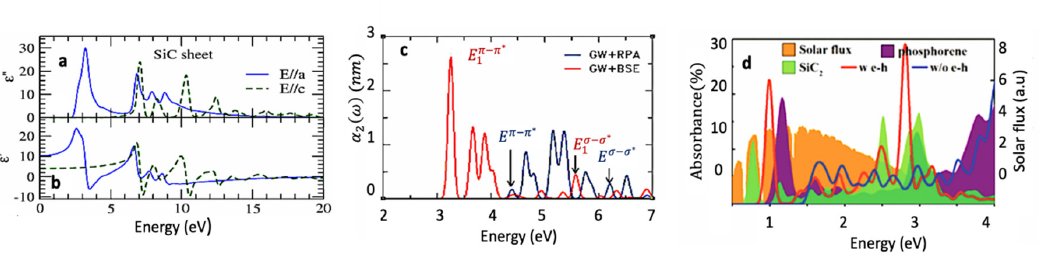
Figure 4. Optical properties of 2D silicon carbide materials. ( a , b ) Dielectric functions vs. photon energy in a single SiC sheet. The imaginary ( a ) and real ( b )parts of the dielectric function for the electric field parallel (blue line) and perpendicular (green line) to the SiC sheet [53]. ( c ) Optical absorption spectra of monolayer SiC using GW + RPA (blue) and GW + BSE (red) calculations [4]. α 2 is related to the imaginary part of the dielectric and it is imaginary part of the polarizability per unit area for a SiC sheet [4]. ( d ) Optical spectra of SiC 7 (orange, red and blue) vs. SiC 2 (green) and phosphorene(purple). Republished with permission of RSC, from [46] permission conveyed through Copyright Clearance Center,